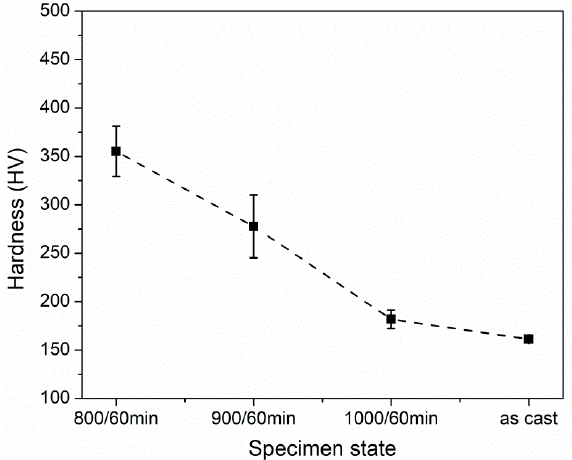
Figure 11. Vicker hardness variation in as-cast and different annealed HEA states.